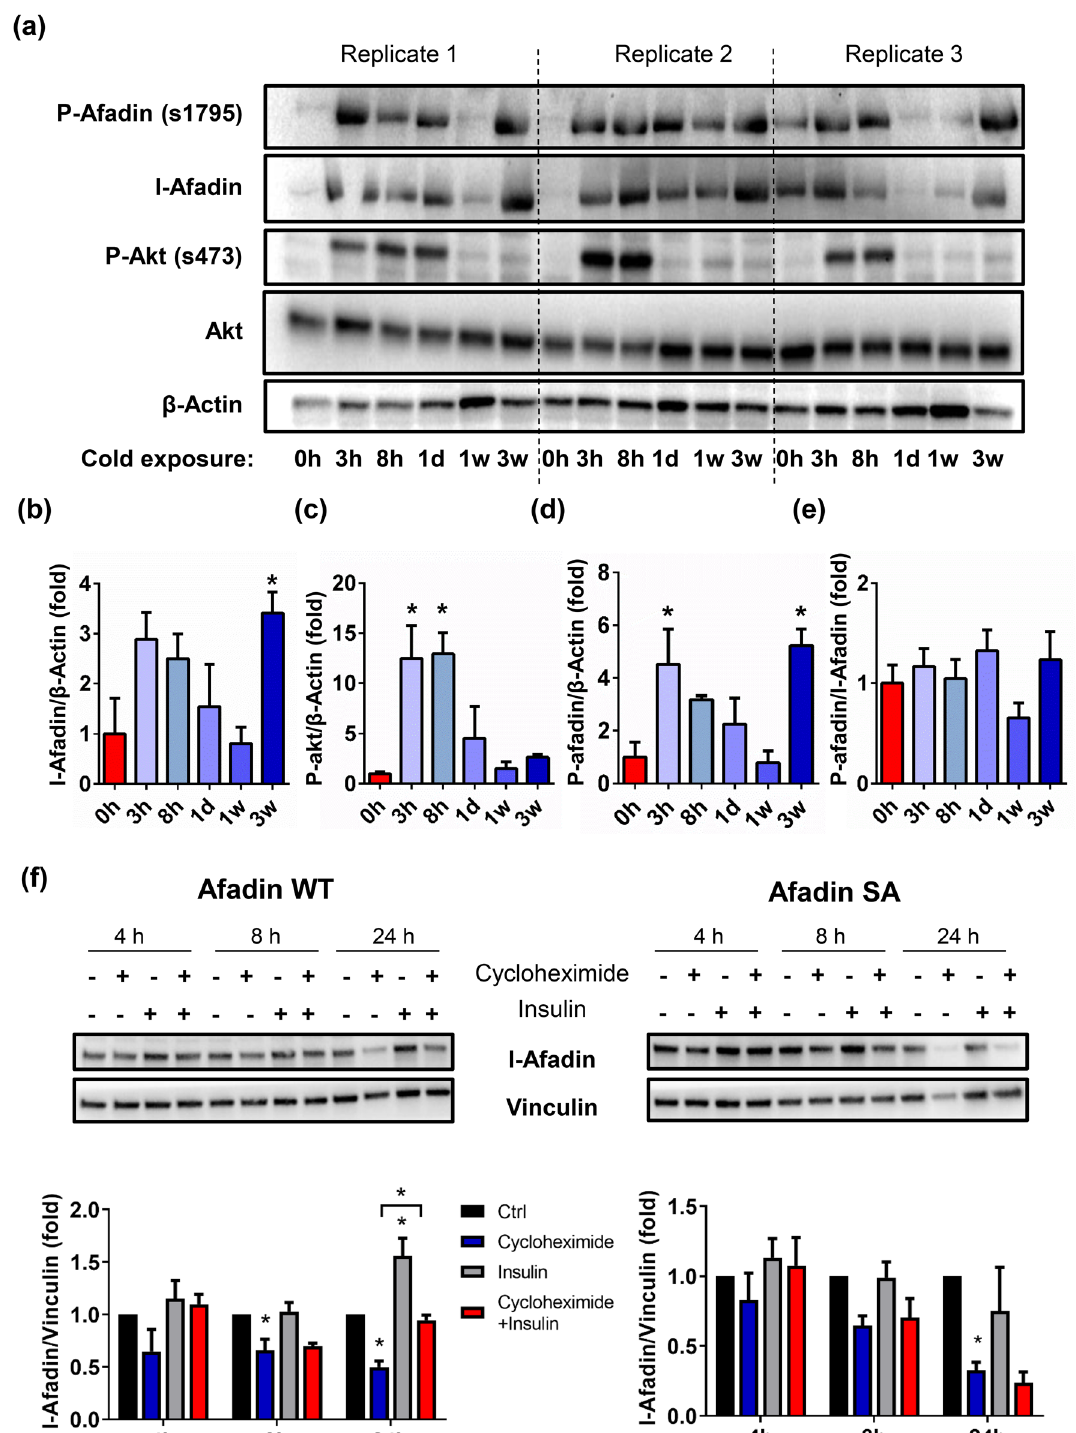
Figure 1. Afadin phosphorylation and abundance are regulated by cold in brown adipose tissue. ( a ) Proteins extracted from BAT were analyzed by SDS-PAGE and ( b ) l-Afadin/β-actin, ( c ) p-Akt//β-actin, ( d ) p-Afadin//β- actin and ( e ) p-Afadin/l-Afadin quantified. ( f ) l-Afadin protein levels in mature adipocytes expressing l-Afadin (Afadin WT) or S1795A l-Afadin (Afadin SA) exposed to vehicle or 10 µg/ml cycloheximide for various time points + /− 100 nM insulin. Representative blots are shown. N = 3. Data are presented as means + SEM, *p < 0.05 vs. 0 h for ( b – e ) and versus ctrl or indicated condition in ( f